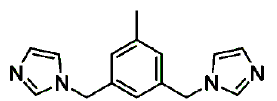
Figure 1. 1,3-Bis(imidazol-1-ylmethyl)-5-methylbenzene ( L ).